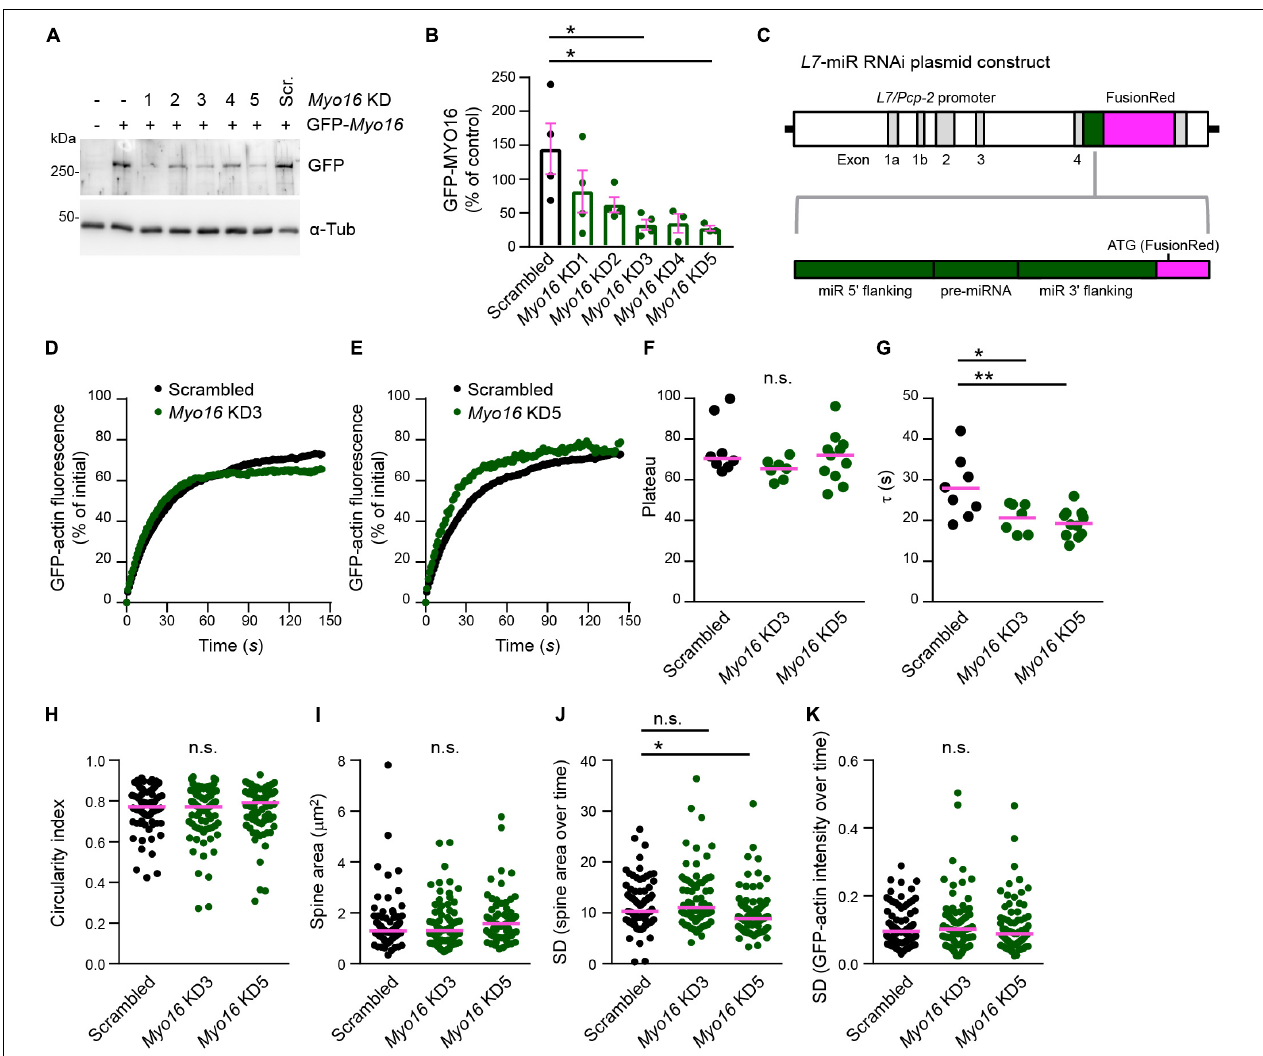
FIGURE 4 | Purkinje cell-specific Myo16 knockdown leads to accelerated F-actin turnover in dendritic spines. (A,B) Identification of Myo16 miR RNAi knockdown constructs. (A) Western blot analysis of HEK293 cells co-transfected with a plasmid encoding mGFP-tagged mouse MYO16 and pcDNA TM 6.2-GW/EmGFP-miR plasmids carrying the indicated knockdown sequences ( Myo16 KD1–KD5) or scrambled control (Scr.). For control, untransfected cells (first lane) and cells transfected only with plasmid encoding mGFP- Myo16 were used. Antibodies against GFP and α -Tubulin ( α -Tub; loading control) were used. (B) Quantification of GFP-MYO16 protein amount upon co-transfection with Myo16 knockdown constructs KD1–KD5 or scrambled control. Graph depicts GFP-MYO16 signals normalized to tubulin signals and expressed as percentage of control (i.e., cells transfected with GFP-MYO16 plasmid only). Bars indicate mean values ( n = 3–4; data points represent experiments) ± SEM (magenta); p values determined using Kruskal–Wallis test ( p = 0.0321) followed by Dunn’s multiple comparisons test. (C) Schematic representation of plasmids for expressing Myo16 KD3, Myo16 KD5 or scrambled sequence ( pre-miRNA ) and flanking miR sequences (green) together with FusionRed as a reporter for RNAi expression (magenta) under control of the PC-specific L7/Pcp-2 promoter. (D,E) FRAP analysis of GFP-actin in spines of wild-type PCs transfected with L7/Pcp-2 promoter plasmids carrying Myo16 KD3, Myo16 KD5, or scrambled sequence and FusionRed (reporter for knockdown construct expression). Cells were co-transfected with a plasmid encoding GFP-actin. Graphs depict recovery of GFP-actin fluorescence intensity in spines, data points represent the mean of a representative experiment. For clarity, recovery curves of Myo16 KD3 (D) and Myo16 KD5 (E) are compared to the same scrambled control but shown in separate graphs. (F) GFP-actin FRAP recovery plateau in spines of PCs transfected as described in (D,E) . Data are plateau values obtained from independent experiments ( n = 7–11; magenta line indicates median); p value determined using Kruskal–Wallis test. (G) GFP-actin FRAP recovery time constant ( τ ) in spines of PCs transfected as described in (D,E) . Data are τ values from independent experiments ( n = 7–11; magenta line indicates mean); p values determined using one-way ANOVA ( p = 0.0038) followed by Tukey’s multiple comparisons test. (H) Circularity index of spines of PCs transfected as described in (D,E) . Data points represent single spines, magenta line indicates median; p value determined using Kruskal–Wallis test. (I) Apparent area covered by single spines of PCs transfected as described in (D,E) . Data points represent single spines, magenta line indicates median; p value determined using Kruskal–Wallis test. (J) Spine area changes over time of PCs transfected as described in (D,E) . Data points represent SD of the relative area change of single spines over 150 s, magenta line indicates median; p values determined using Kruskal–Wallis test ( p = 0.0008) followed by Dunn’s multiple comparisons test. (K) Change of GFP-actin fluorescence intensity over time in spines of PCs transfected as described in (D,E) . Data points represent SD of the relative fluorescence change of single spines monitored over 150 s, magenta line indicates median. For reasons of comparability with the other figures, a single data point of Myo16 KD5 lying above the Y -axis limit is not shown; p value determined using Kruskal–Wallis test. ∗ p < 0.05; ∗∗ p < 0.01; ∗∗∗ p < 0.001; ∗∗∗∗ p < 0.0001; n.s., not